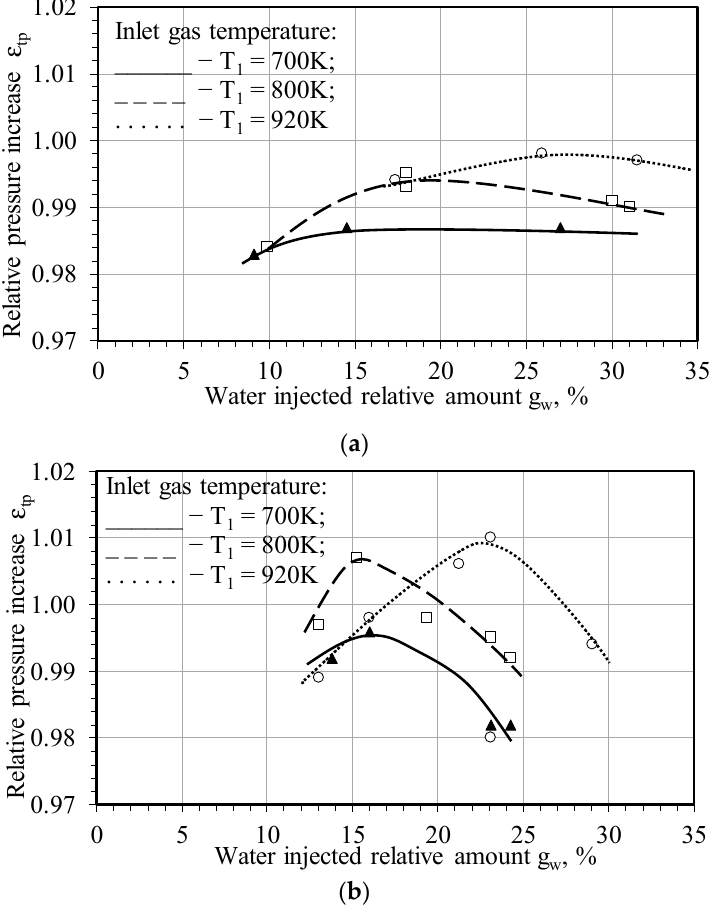
Figure 1. The pressure relative increase ratio ε tp = P 2 /P 1 in the flowing part on the water injected relative amount g w : ( a ) Ma = 0.45; ( b ) Ma = 0.70; ▲ – T 1 = 700 K; □ – T 2 = 800K; ○ – T 3 = 920 K.